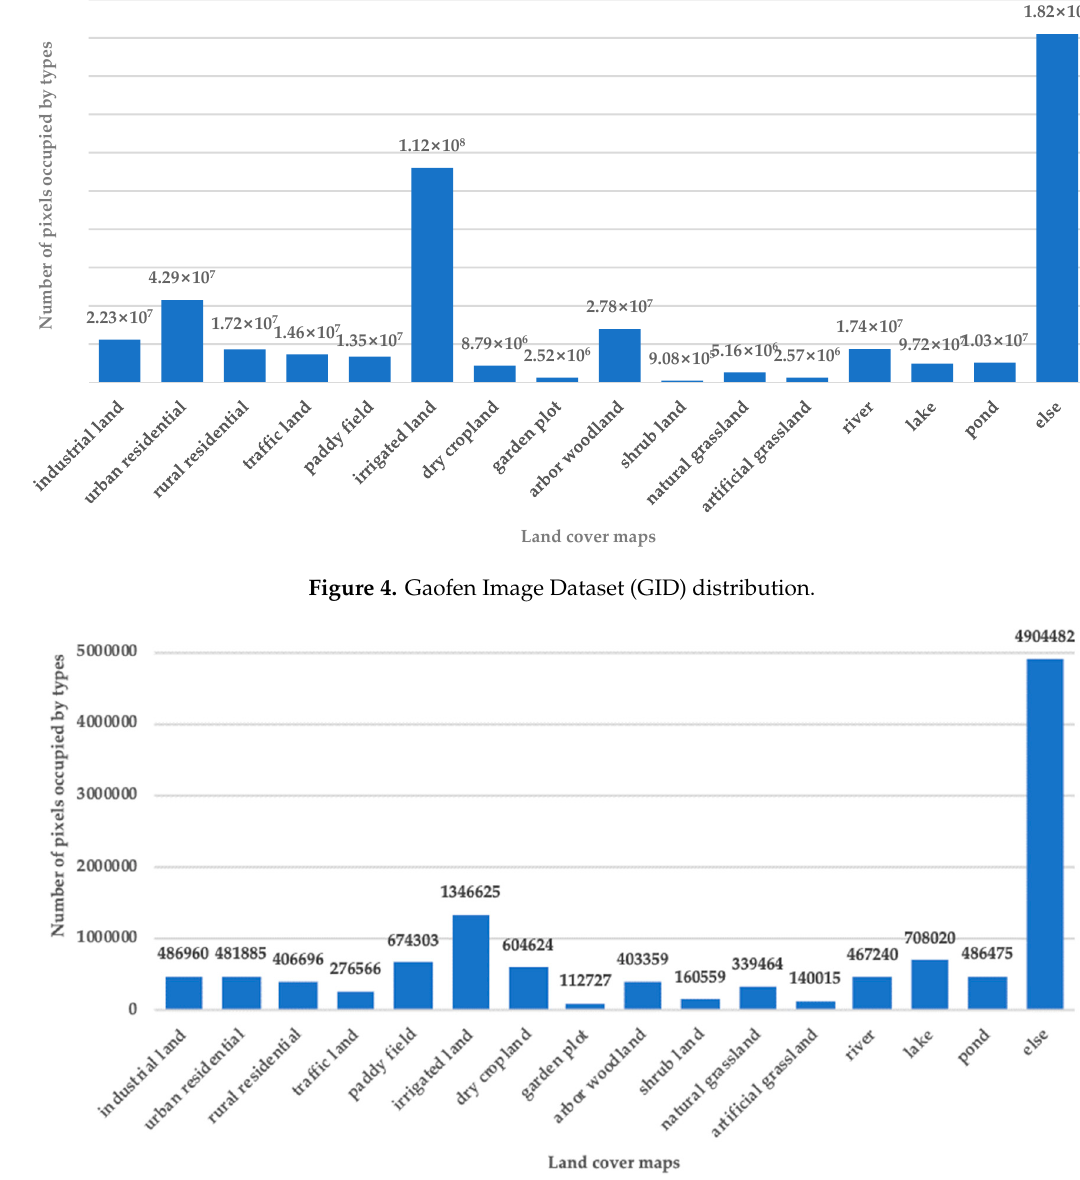
Figure 5. Validation set